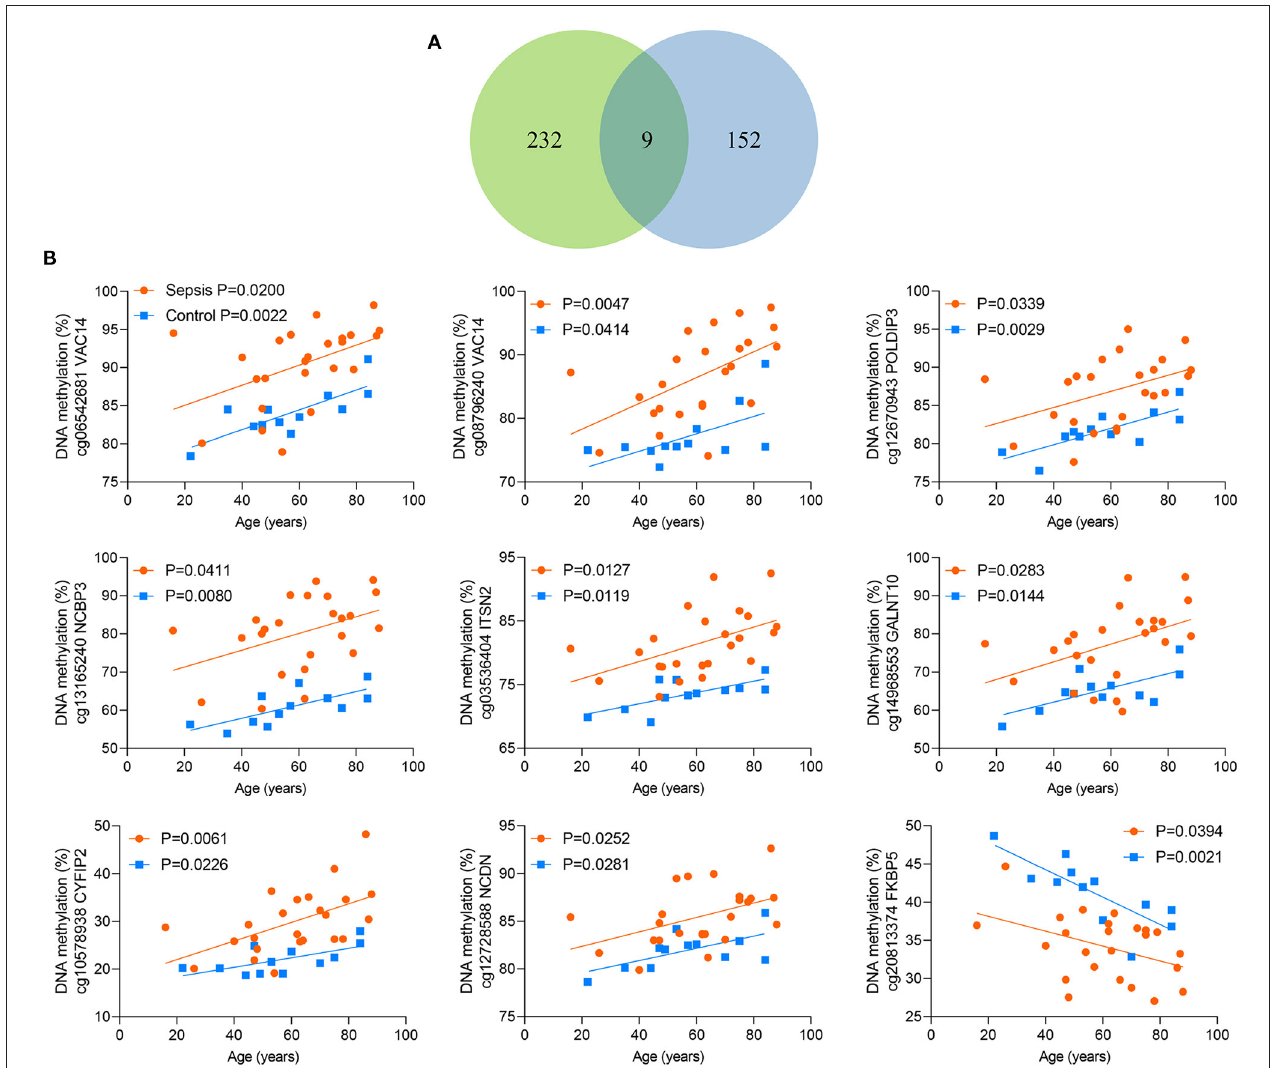
FIGURE 5 | Nine shared CpG sites. (A) Venn diagram showing the intersection of the sets of 241 age-related CpG sites in controls and 161 age-related CpG sites in sepsis patients. (B) Correlation between age and methylation of 9 CpG sites as analyzed by linear regression